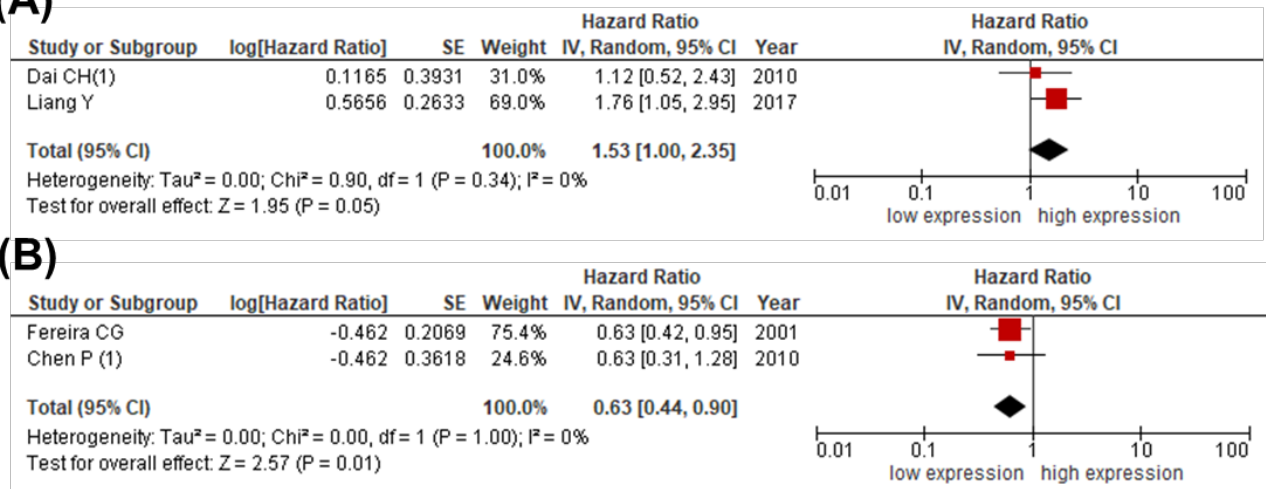
Figure 5. Meta-analysis comparing expression of ( A ) livin and ( B ) XIAP with OS in patients with lung cancer. The forest plot reflects the individual and pooled HR with 95% CI. Heterogeneity was measured by the Cochrane Q test (Chi-squared test; Chi 2 ) and inconsistency (I 2 ).